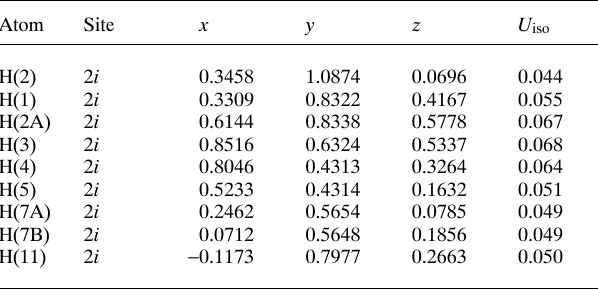
Table 2. A tomic coordin a tes a nd displ a cement p a r a meters (in Å 2 )